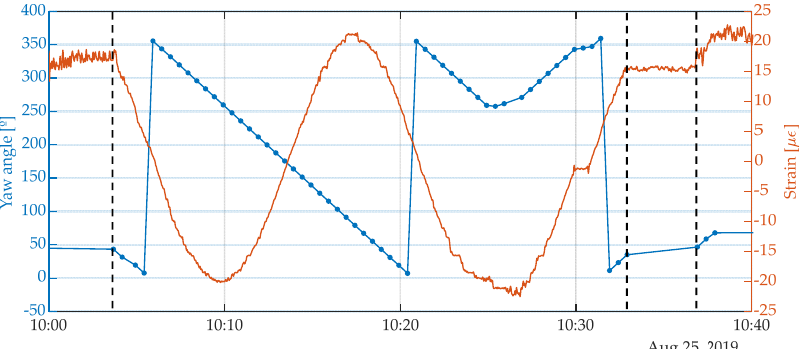
Figure 6. Synchronization of the SCADA data (yaw angle high-resolution) and cRIO system (strain gauge A) (the vertical dashed lines correspond to the singular points used for synchronization).